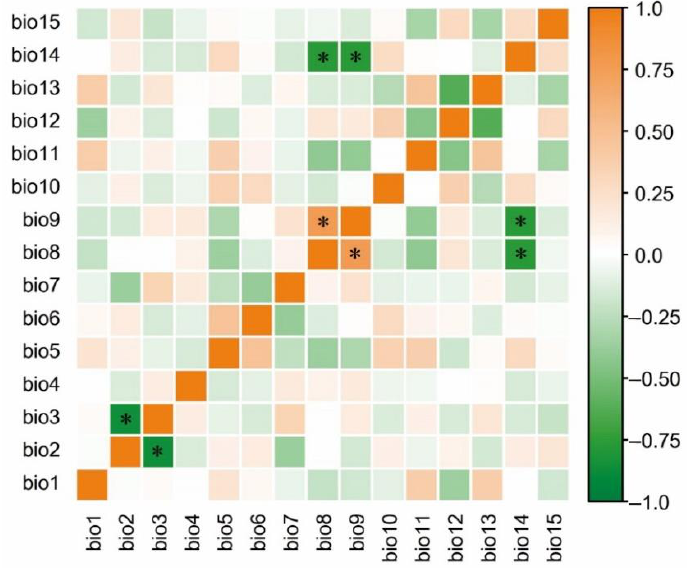
Figure 3. Heat map of the coefficients of correlation between environmental variables. (* means the spearman coefficient is greater than or equal to